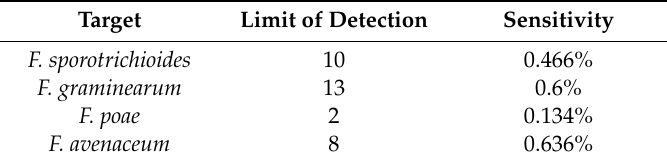
Table 4. Limit of detection expressed as copies / µ L and sensitivity of the four cdPCR assays.